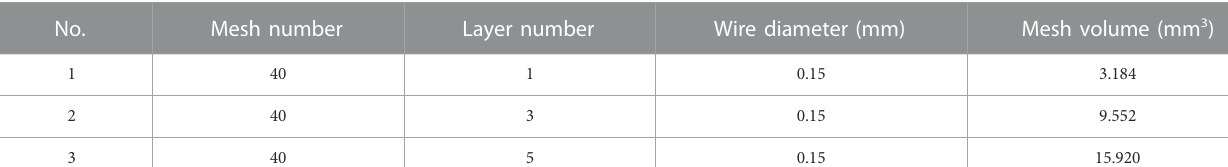
TABLE 1 Parameters of experimental metal wire mesh.